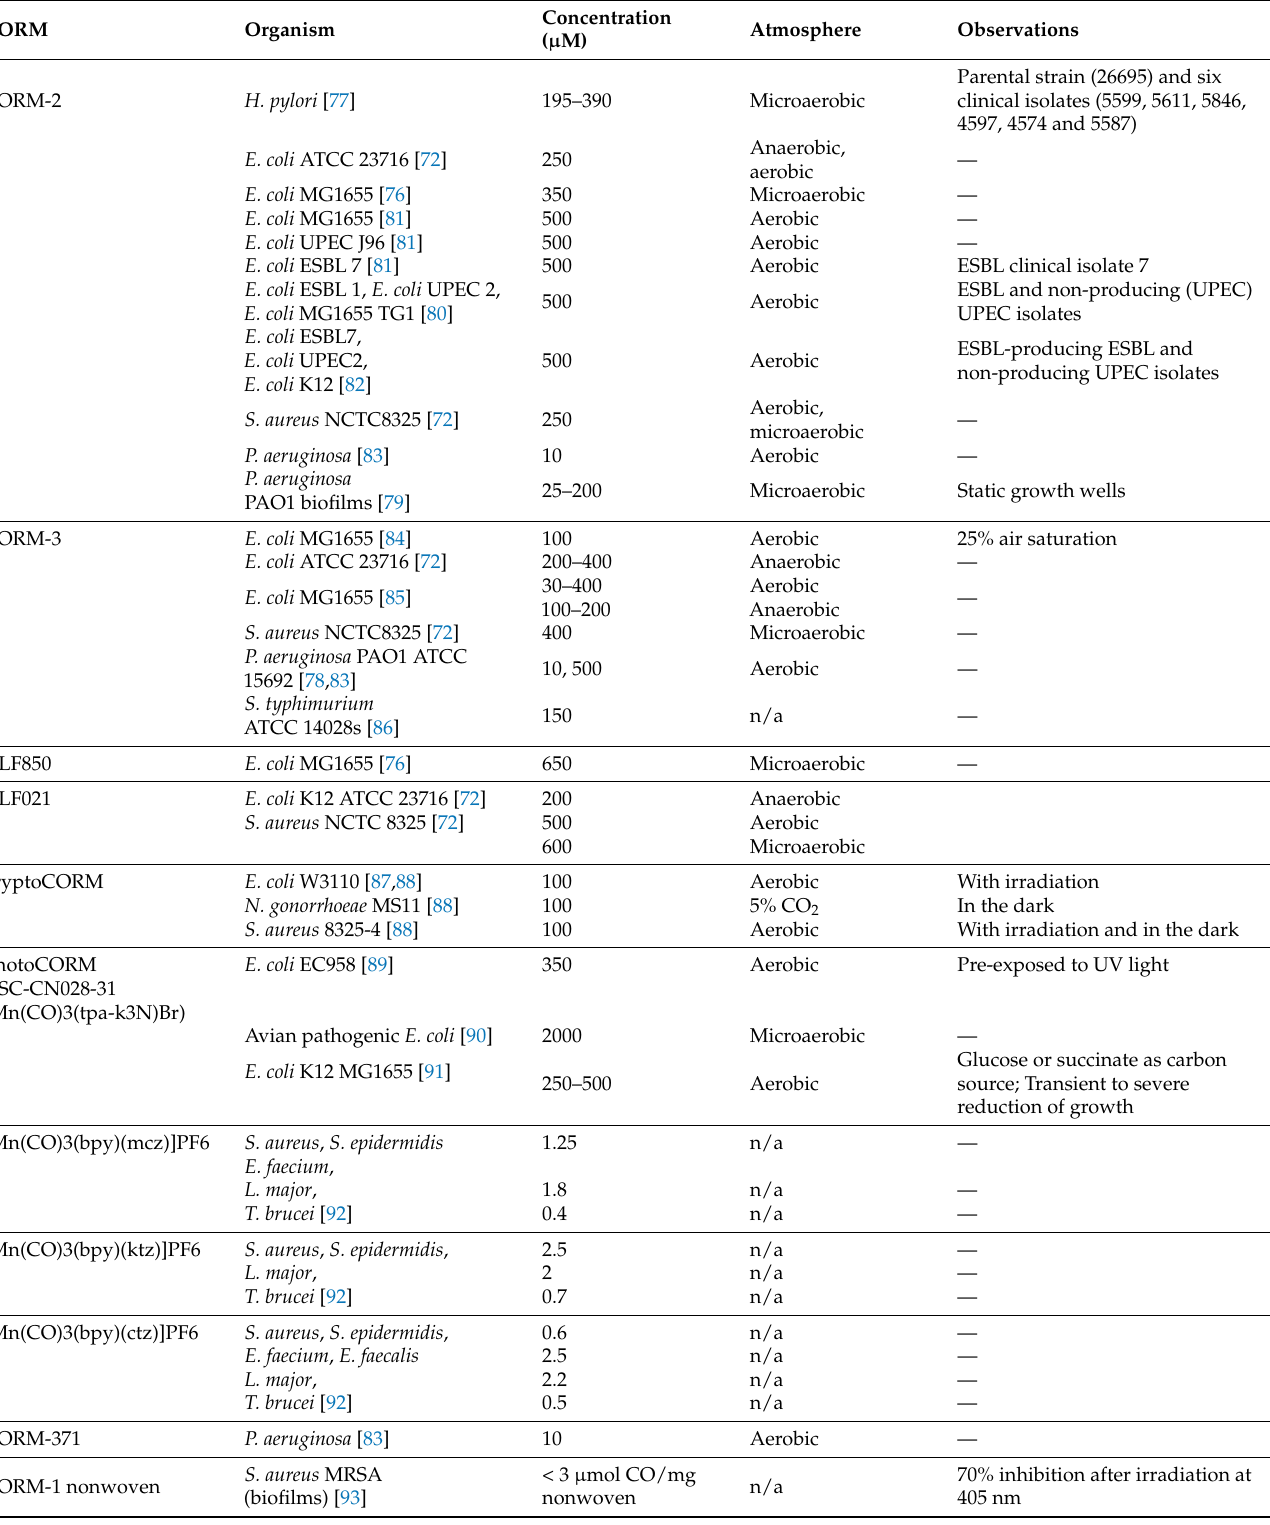
Table 1. CORMs used as